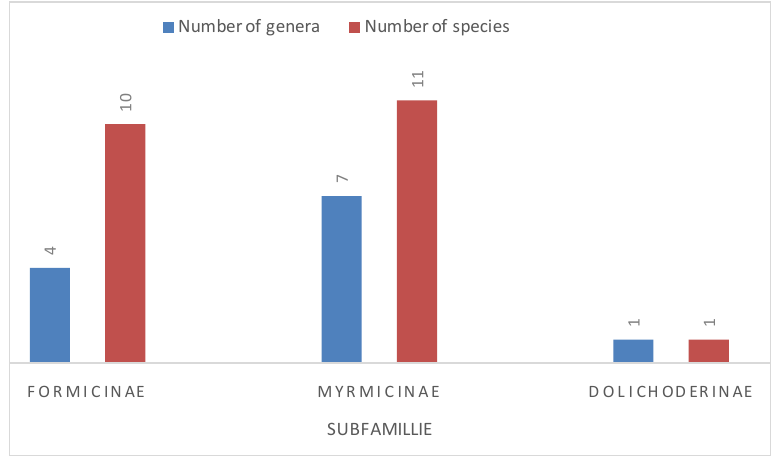
Fig 3 . Number of genera and species for each subfamily in the two study sites.